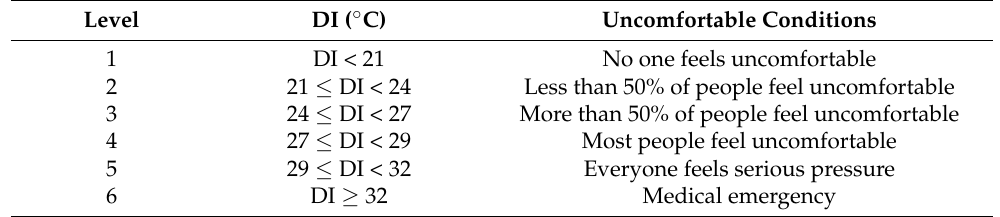
Table 1. Discomfort Index Classification